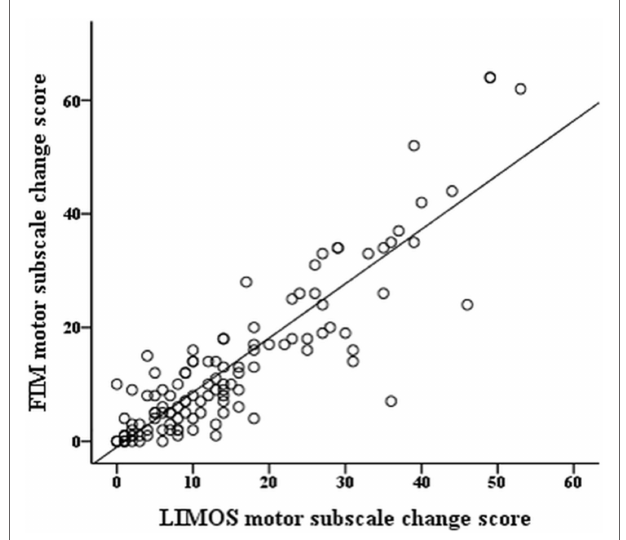
FigUre 1 | liMOs motor subscale change correlates significantly with a change in the FiM motor subscale .